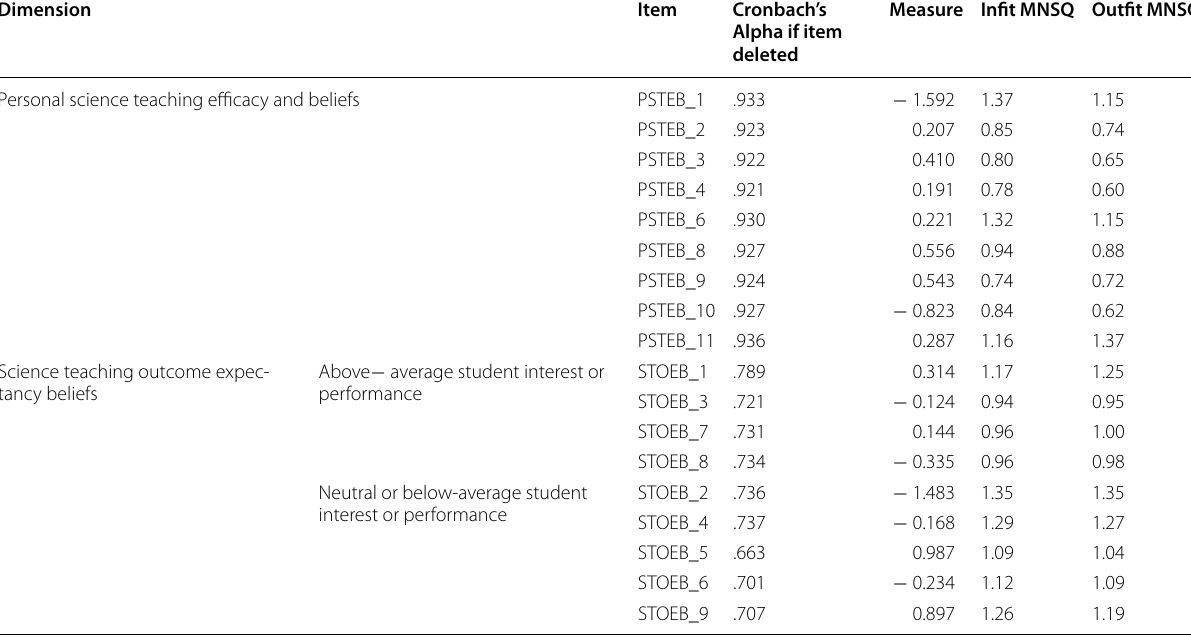
PSTEB_5 and PSTEB_7 were removed based on the prior analysis